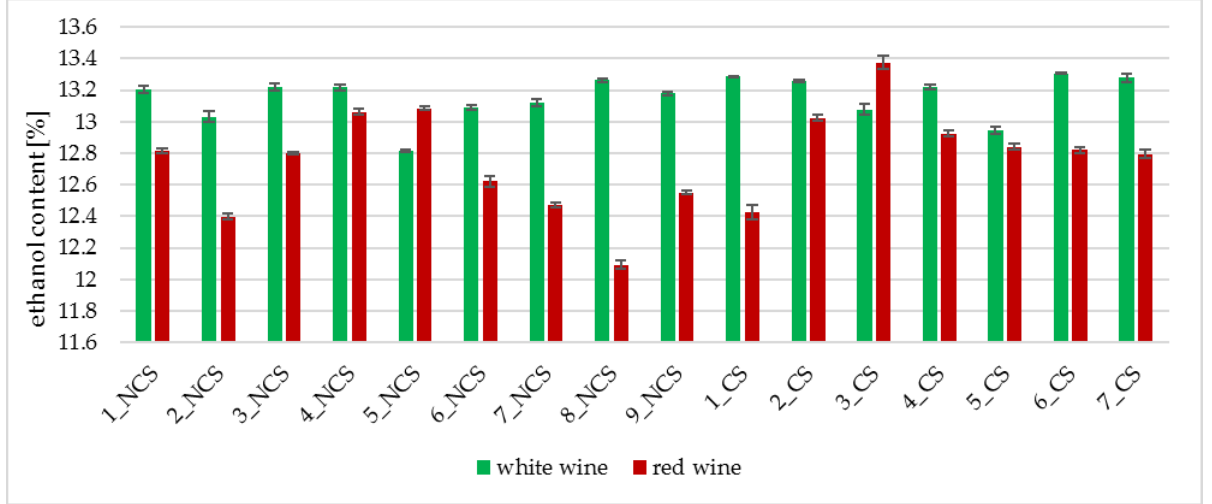
Figure 2. Ethanol content of white and red wines.